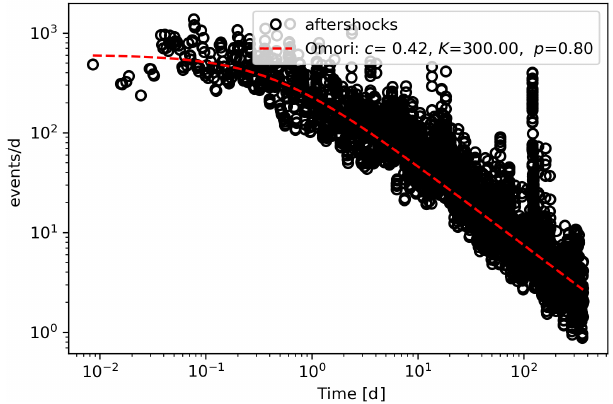
Figure 14. The modified Omori formula aftershock attenuation curve of the Wenchuan